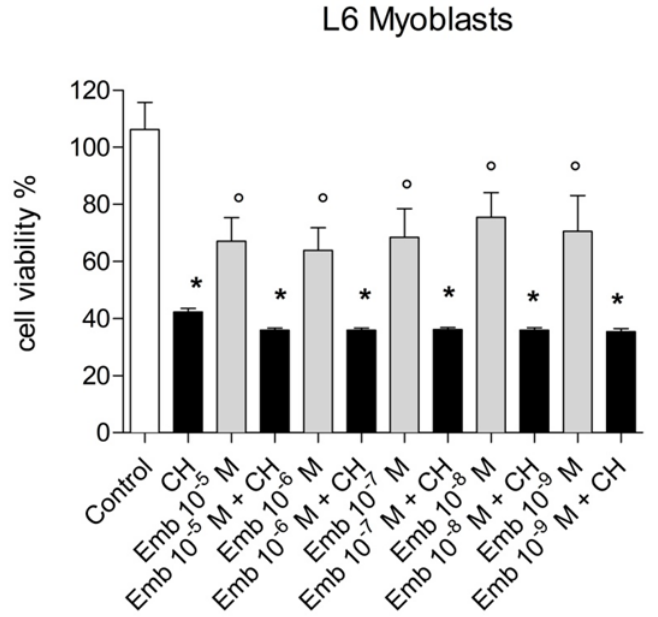
Figure 20. Cytotoxicity/proliferation (the MTT) assay carried out with embelin in the range 10 -6 – 10 -9 M in L6 myoblasts. The concentration of cumene hydroperoxide (CH) was 27.5µM throughout the experiments. Results are the mean ± SD of two different experiments carried out in quintuplicate. *p <0.001 vs. all, °p < 0.01 vs. control.